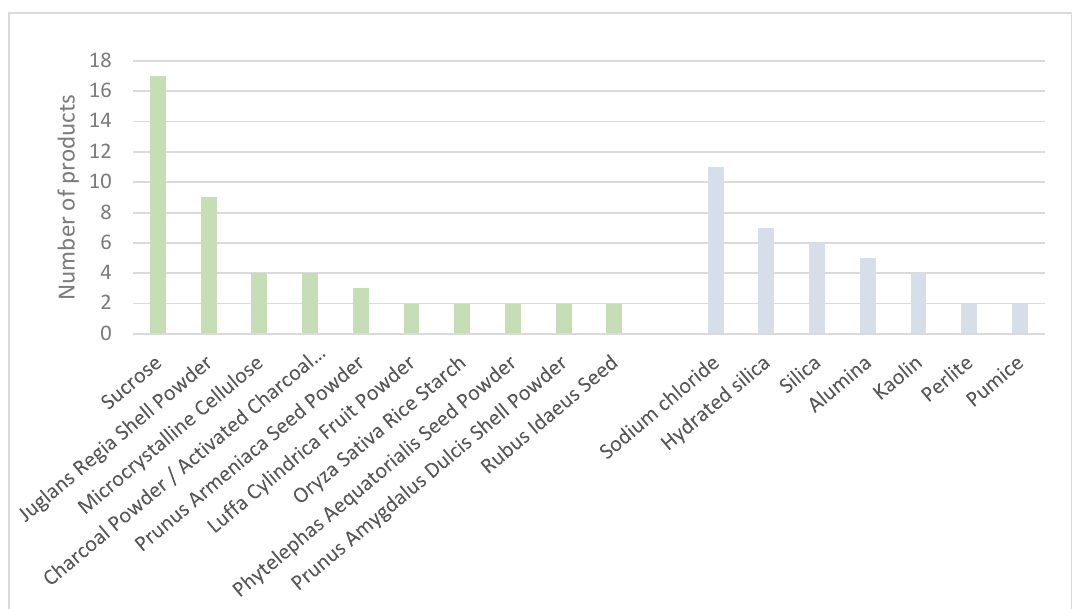
Figure 2. Division of abrasive ingredients taking into account the frequency of occurrence in the analyzed cosmetic products and the source of origin. Green color indicates vegetable raw materials, gray color represents mineral raw materials.